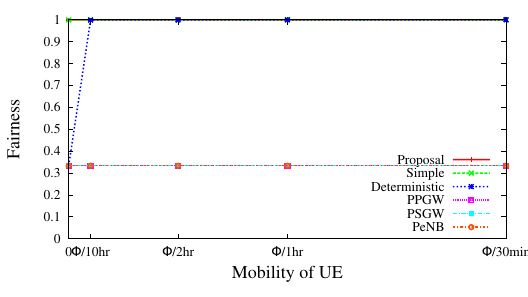
Figure 12: Fairness in Scenario 1 ( ρ = 0 . 5 )